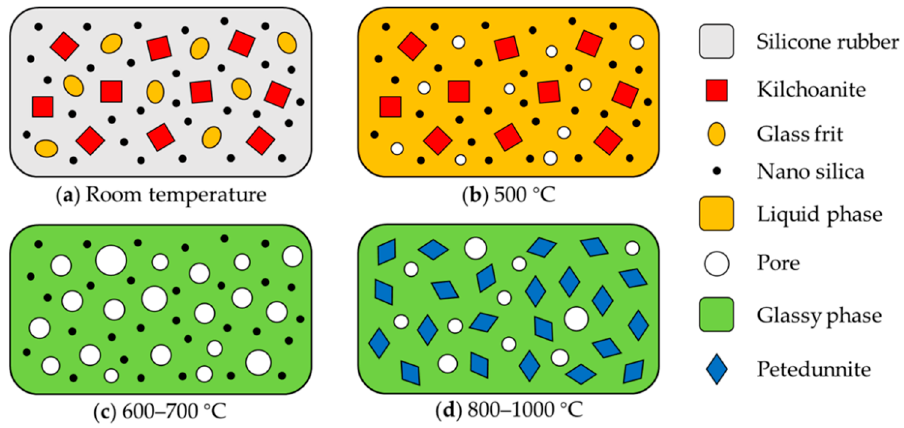
Figure 7. Ceramization process and mechanism of ceramizable silicone rubber composites.